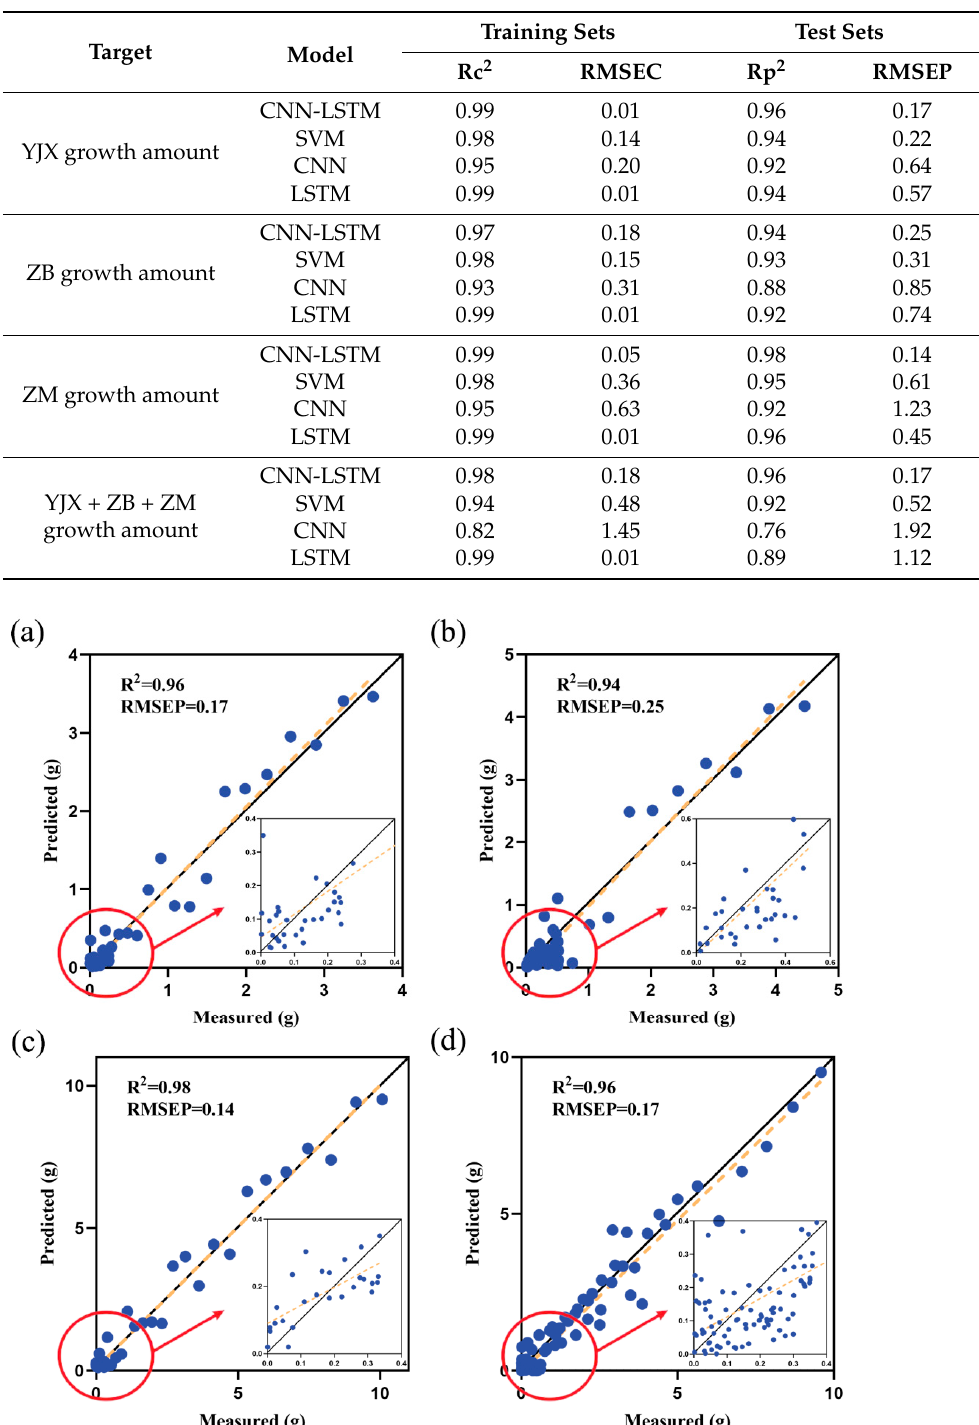
Table 2. Evaluation of model accuracy.